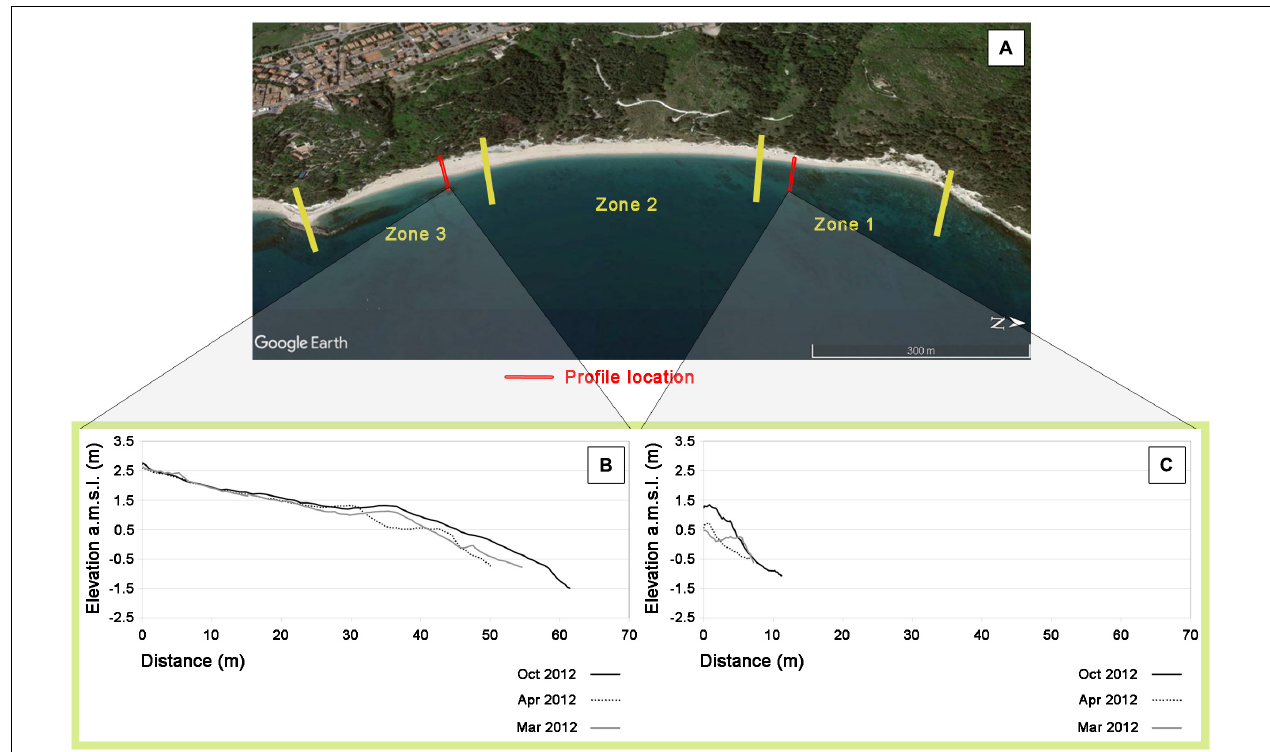
FIGURE 5 | Profile variation at the edge zones of Sirolo beach between March and October 2012: (A) zone subdivision and profile location; (B) profile variation in zone 3; (C) profile variation in zone 1. Profiles have been chosen according to the larger topographic variation